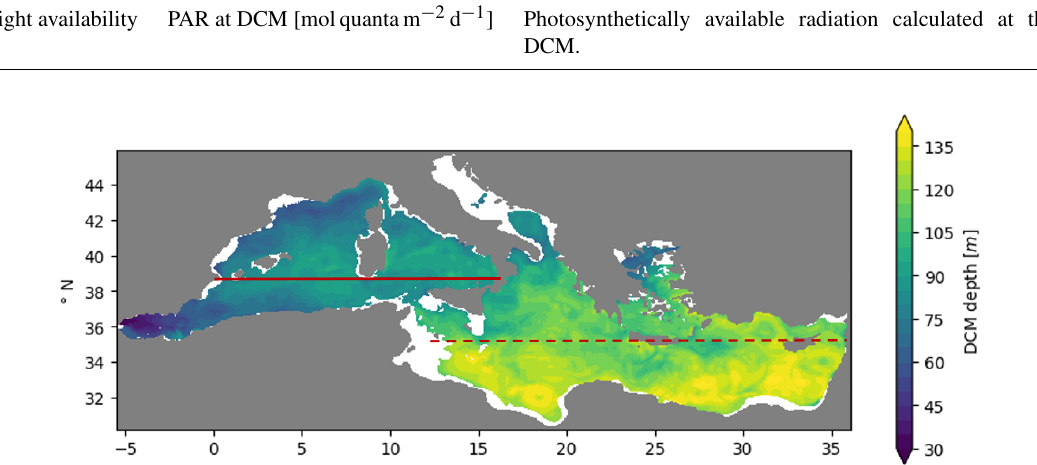
Figure 8. Mean DCM depth [m] calculated over summer in areas with water depths lower than 200m. Western and eastern meridional averages of Fig. 9 are calculated along red continuous and dashed lines, respectively, excluding the Adriatic (ADR) and Aegean (AEG)